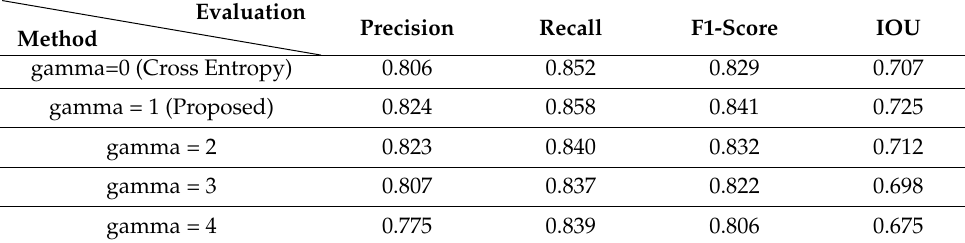
Table 9. Performance of focal loss between different gamma